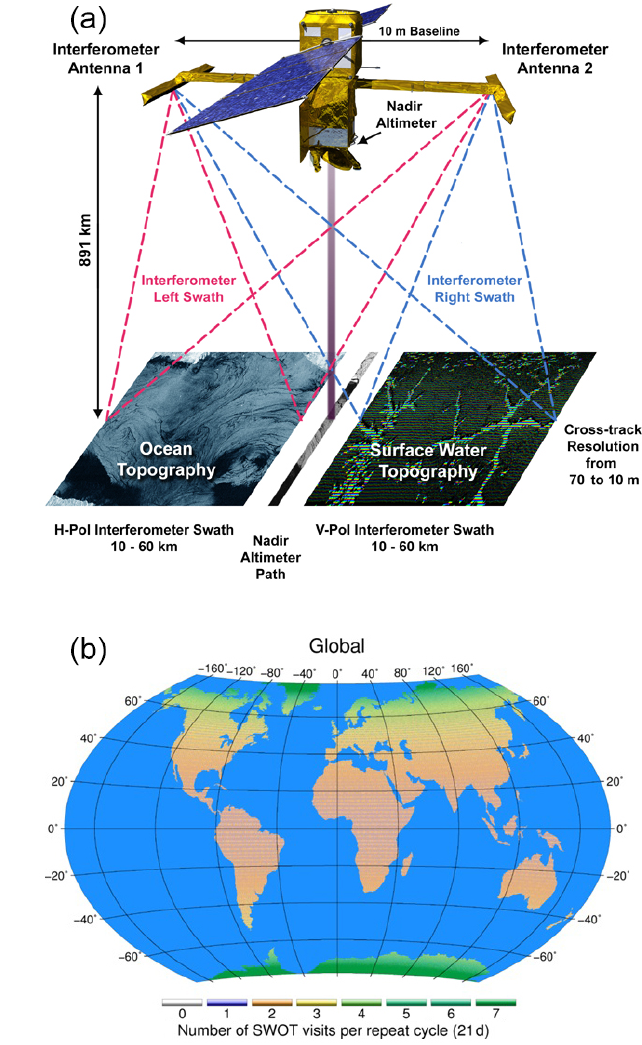
Figure 3. (a) Principes de la mesure SWOT (en haut). (b) Couver- ture spatiale et temporelle de SWOT (nombre de revisites de SWOT par cycle de 21 jours) (en